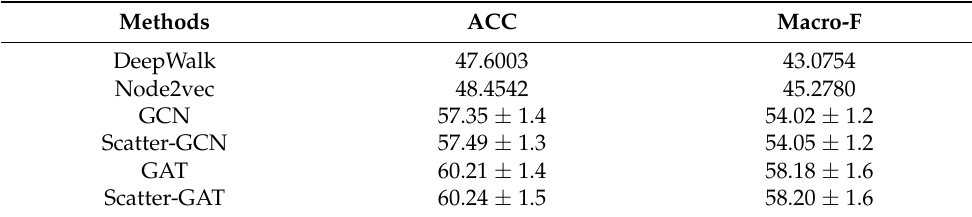
Table 2. Evaluation on edge graph link prediction (%) using GNN as the base model.